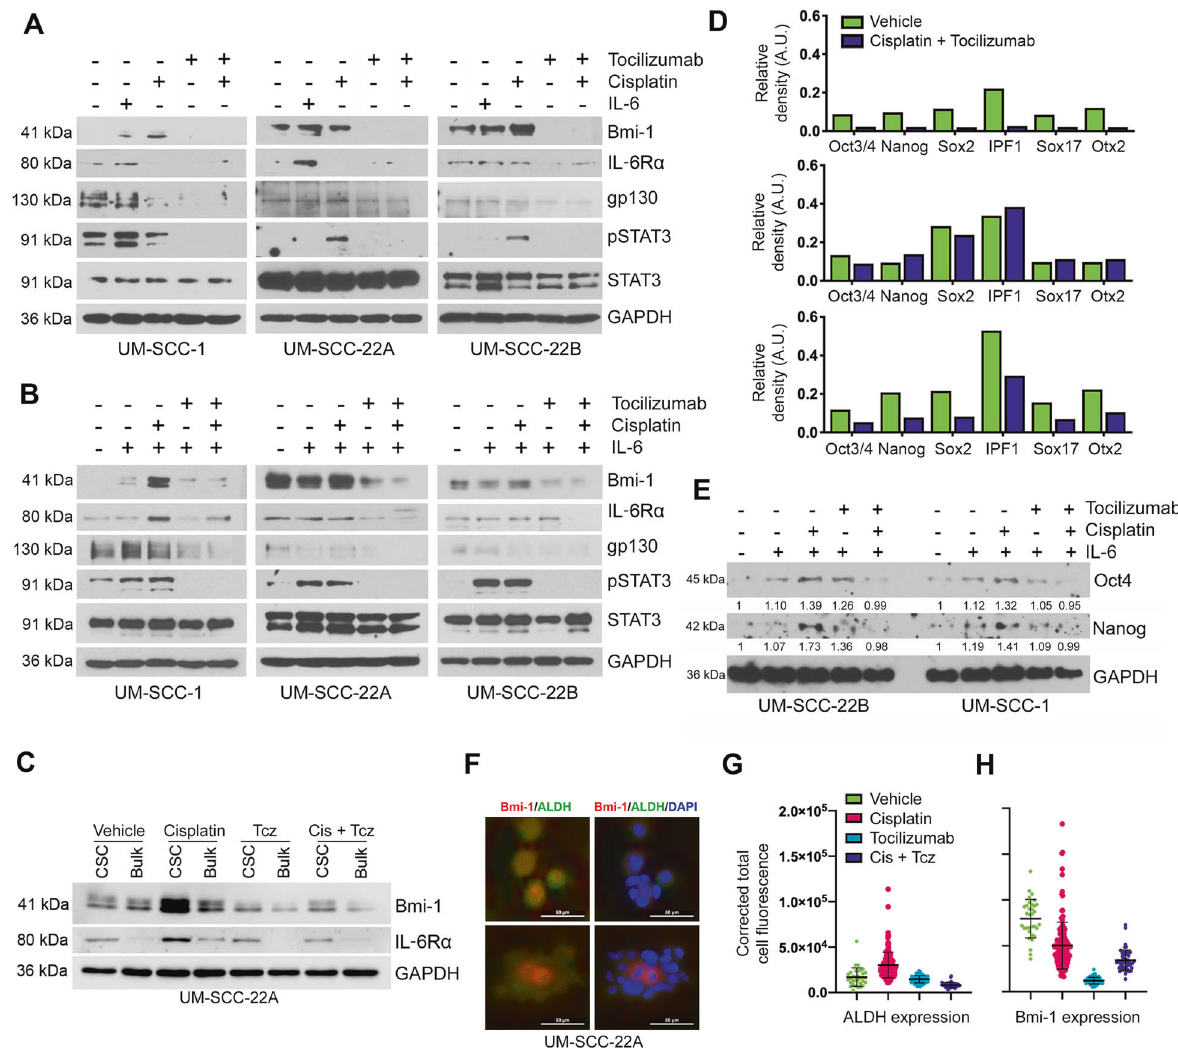
Fig. 3 IL-6R blockade with Tocilizumab suppresses Cisplatin-induced stemness in vitro. A Western blot analyses of Bmi-1, IL-6R, gp130, pSTAT3, and STAT3 in UM-SCC-1, UM-SCC-22A, and UM-SCC-22B cells treated with vehicle, rhIL-6 (20 ng/ml), Cisplatin (1 µM), and/or Tocilizumab (0.1 µM). B Western blot analysis of UM-SCC-1, UM-SCC-22A, and UM-SCC-22B cells treated with rhIL-6 (20 ng/ml) combined with vehicle, Cisplatin (1 µM), and/or Tocilizumab (0.1 µM) for 24 h, followed by additional rhIL-6 (20 ng/ml) for 24 h. C Western blottings to evaluate the effect of 1 µM Cisplatin and/or 0.1 µM Tocilizumab on UM-SCC-22A cells sorted for ALDH/CD44. D Stem cell marker protein array analysis of UM-SCC-1, UM-SCC-22A, and UM-SCC-22B cells treated with Cisplatin (1 µM) and Tocilizumab (0.1 µM), as compared to vehicle controls. E Western blot analysis of stem cell markers (Oct4 and Nanog) in UM-SCC-1 and UM-SCC-22B cells treated with rhIL-6 (20 ng/ml), Cisplatin (1 µM), and/or Tocilizumab (0.1 µM). F Representative images of immuno fl uorescence staining (Bmi-1 and ALDH1) of UM-SCC-22A cells plated in chamber slides and treated with Cisplatin (0 – 1 µM) and/or Tocilizumab (0 – 0.1 µM). G Graph quantifying mean cellular fl uorescence of ALDH1 expression normalized to DAPI in UM-SCC-22A cells treated with Cisplatin (1 µm) and/or Tocilizumab (0.1 µM). H Graph quantifying mean cellular fl uorescence of Bmi-1 normalized to DAPI stain in UM-SCC-22A cells treated with Cisplatin (1 µM) and/or Tocilizumab (0.1 xenograft tumors (Fig. 6C, D) and extended time to tumor volume doubling (Fig. 6E). In the resistant tumor model, Cisplatin was less effective in inhibiting tumor growth (Fig. 6C, D). In UM-SCC-22B- naive tumors, Cisplatin suppressed tumor growth more potently during earlier doses and was later observed to lose ef fi cacy in inhibiting tumor growth. The combination therapy approach was most effective in both xenograft models. Western blotting analyses of tumor tissue lysates showed that Cisplatin induced Bmi-1 expression in UM-SCC-22B-naive tumors (Fig. 6F). After treatment with Tocilizumab, both STAT3 and Bmi-1 expression were inhibited in UM-SCC-22B tumors (Fig. 6G and Supplementary Fig. S7A – F). These data support our fi ndings from our experiments